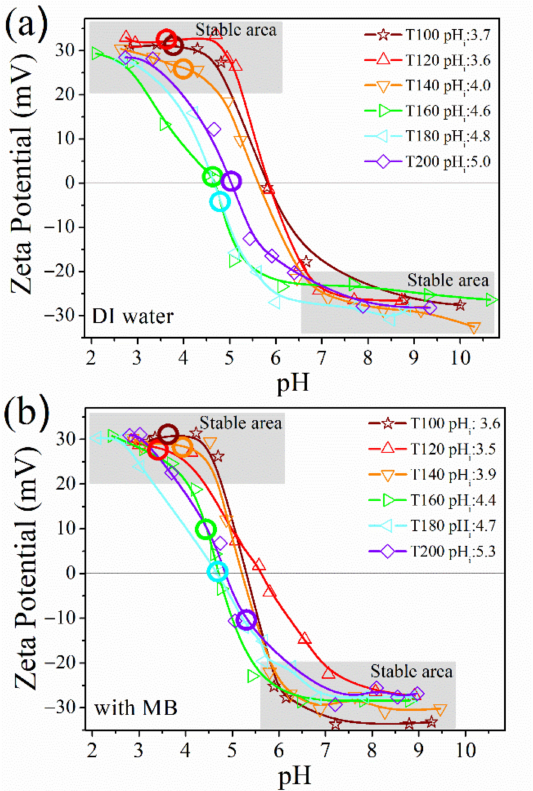
Figure 5. The influence of the solution pH on the ζ -potential of TiO 2 NP dispersions ( a ) deionized water and ( b ) with methylene blue. The open circle indicates the point before starting the titration (as-dispersed TiO 2 NPs), and their initial pH (pH i ) is